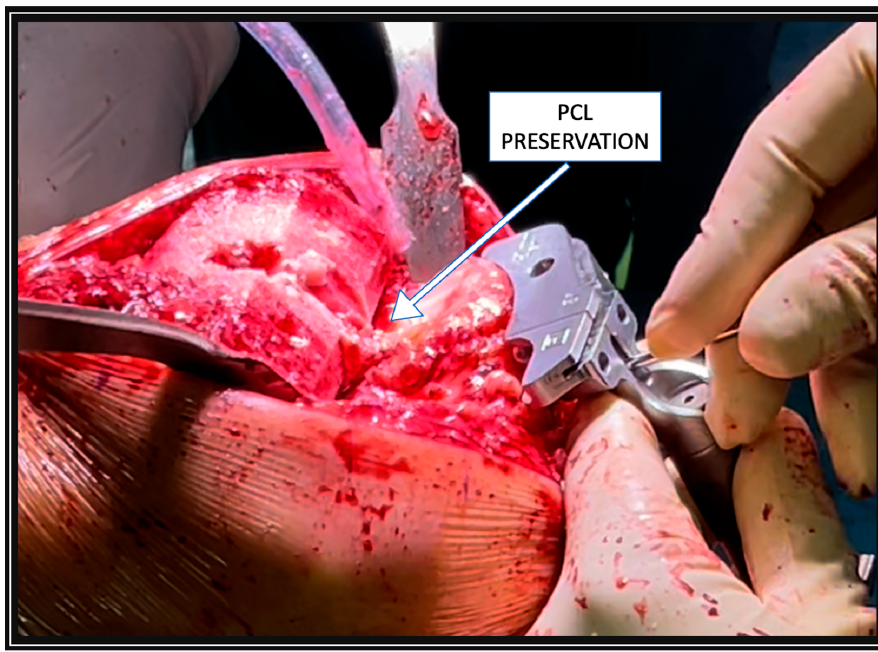
Figure 1. The posterior cruciate ligament (PCL) was preserved during tibial cutting. A median skin incision was performed, approximately three centimeters (cm) proximal to the femoral trochlea and four to five cm above the proximal tibia joint line, followed by a medial parapatellar arthrotomy to achieve adequate exposure. Bone cuts were made after adequate exposure and protection of the posteromedial corner, collateral